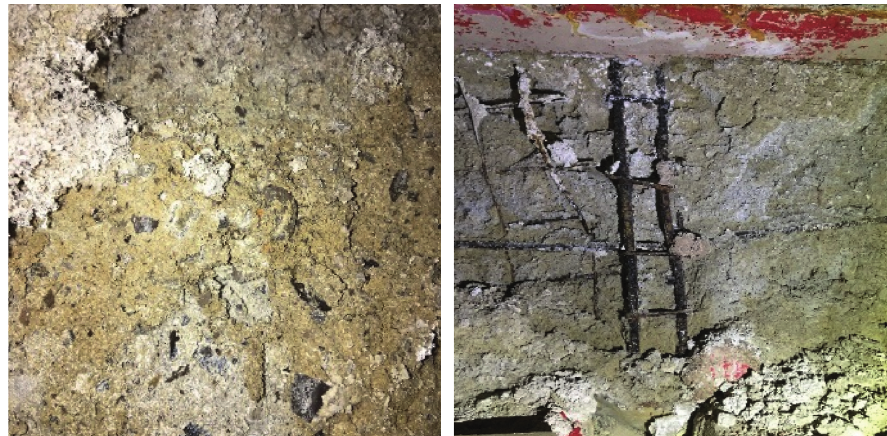
Figure 5: Corrosion of tunnel lining